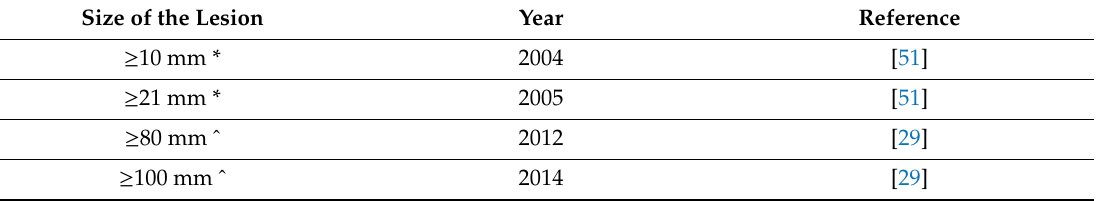
Table 2. Changes in size of the lesion recommended for treatment over